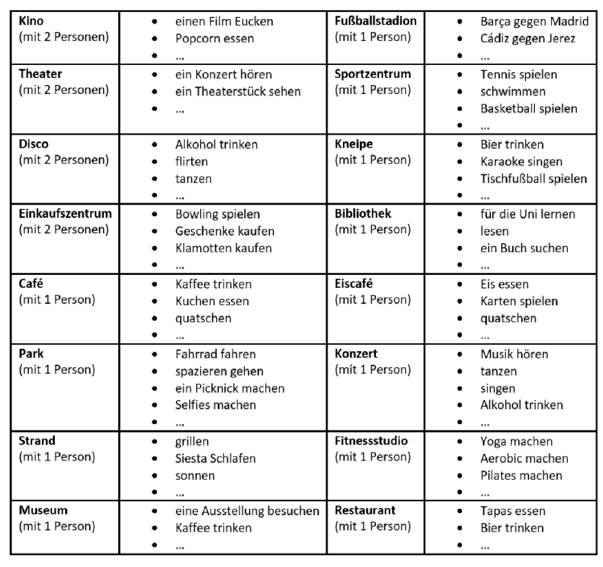
Figure 1. Personal student agenda in its paper version.